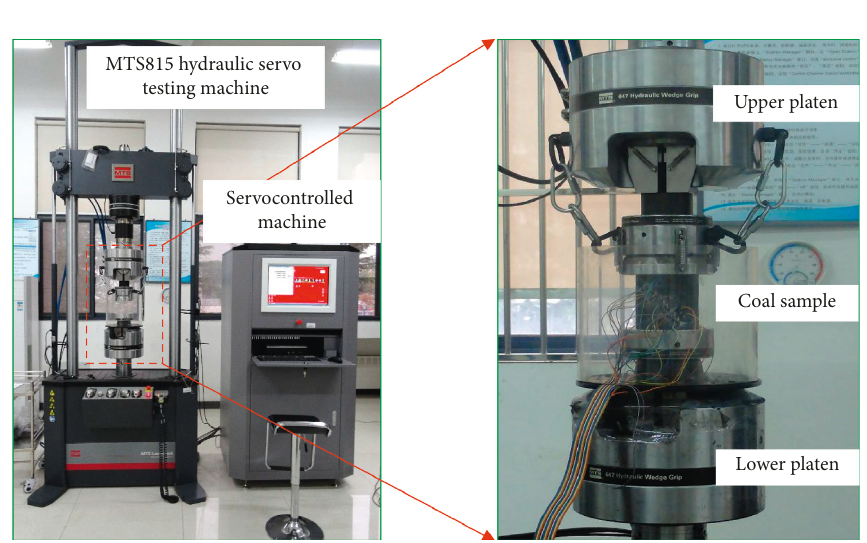
Figure 7: Vibration experiment of